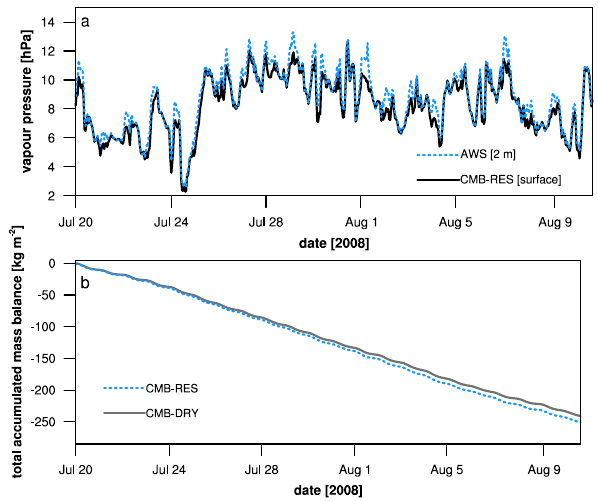
Fig.5. Timeseriesfromthe2008simulationof (a) surface(dashed- Figure 5. Time series from the 2008 simulation of (a) surface blue curve) and 2m air (black curve) vapour pressure [ hPa ] in (dashed-blue curve) and 2m air (black curve) vapour pressure (hPa) CMB-RES, and (b) total accumulated mass balance [ kgm − 2 ] for CMB-DRY(solid-greycurve)andCMB-RES(dashed-bluecurve). in CMB-RES, and (b) total accumulated mass balance (kgm − 2 ) for CMB-DRY (solid-grey curve) and CMB-RES (dashed-blue